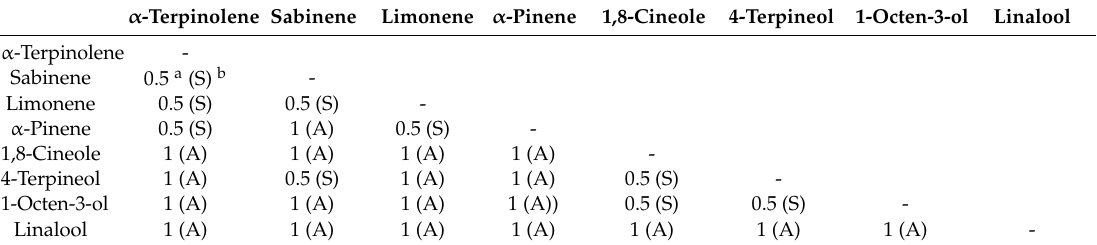
Table 3. Interactive e ff ects of individual compounds on the AChE inhibition. α -Terpinolene Sabinene Limonene α